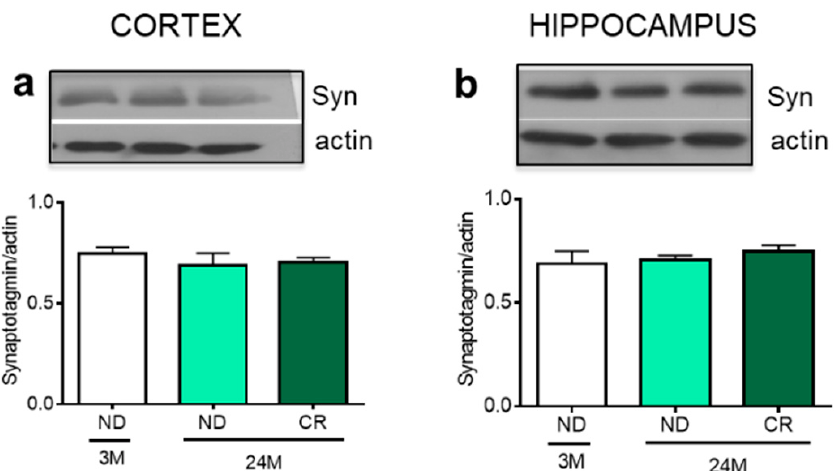
Figure 6. No effect of age and CR on Synaptotagmin in rat cortex and hippocampus. Representative Western blots and densitometric analyses of synaptotagmin in the cortex ( a ) and hippocampus ( b ) normalized to actin levels as loading control. 3M (3-month-old rats); 24M (24-month-old rats); ND (normal diet); CR (caloric intake reduced by 40% for the last 6 months of life). Lastly, we measured the level of brain-derived neurotrophic factor (BDNF), a neu- rotrophin that controls neuronal survival, differentiation, and function during brain de- velopment and in adulthood [32]. The levels of the precursor pro-BDNF decreased with age in both brain regions (cortex: p < 0.01; Df = 9; q = 5.621 vs. 3M ND; hippocampus: p < 0.01; Df = 9; q = 5.234 vs. 3M ND), without reversal of these changes by CR (cortex: p < 0.01; Df = 9; q = 5.354 vs. 3M ND; hippocampus: p < 0.01; Df = 9; q = 5.841 vs. 3M ND) (Figure 7a,b).